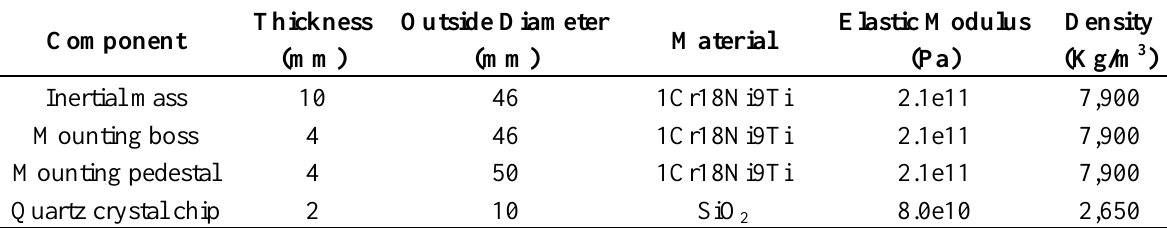
Table 1. Main structural parameters of the six-DOF accelerometer